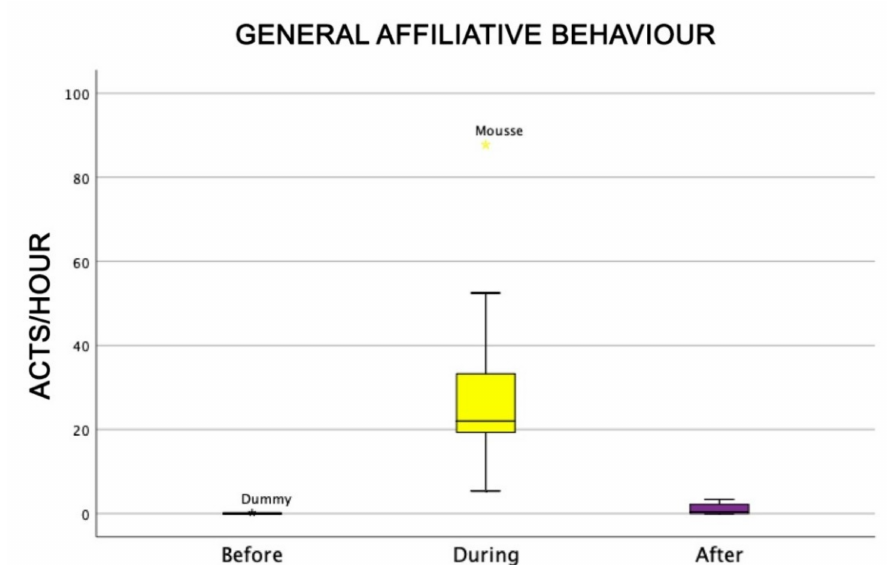
Figure 5. Behavioural patterns related to dogs’ general a ffi liative behaviour before, during, and after AAI sessions. Non parametric data are represented as medians (horizontal bar in the box) and the box indicates the interquartile range of 50% of the data. Whiskers extend to the smallest and largest values and exclude outliers (dot on top).